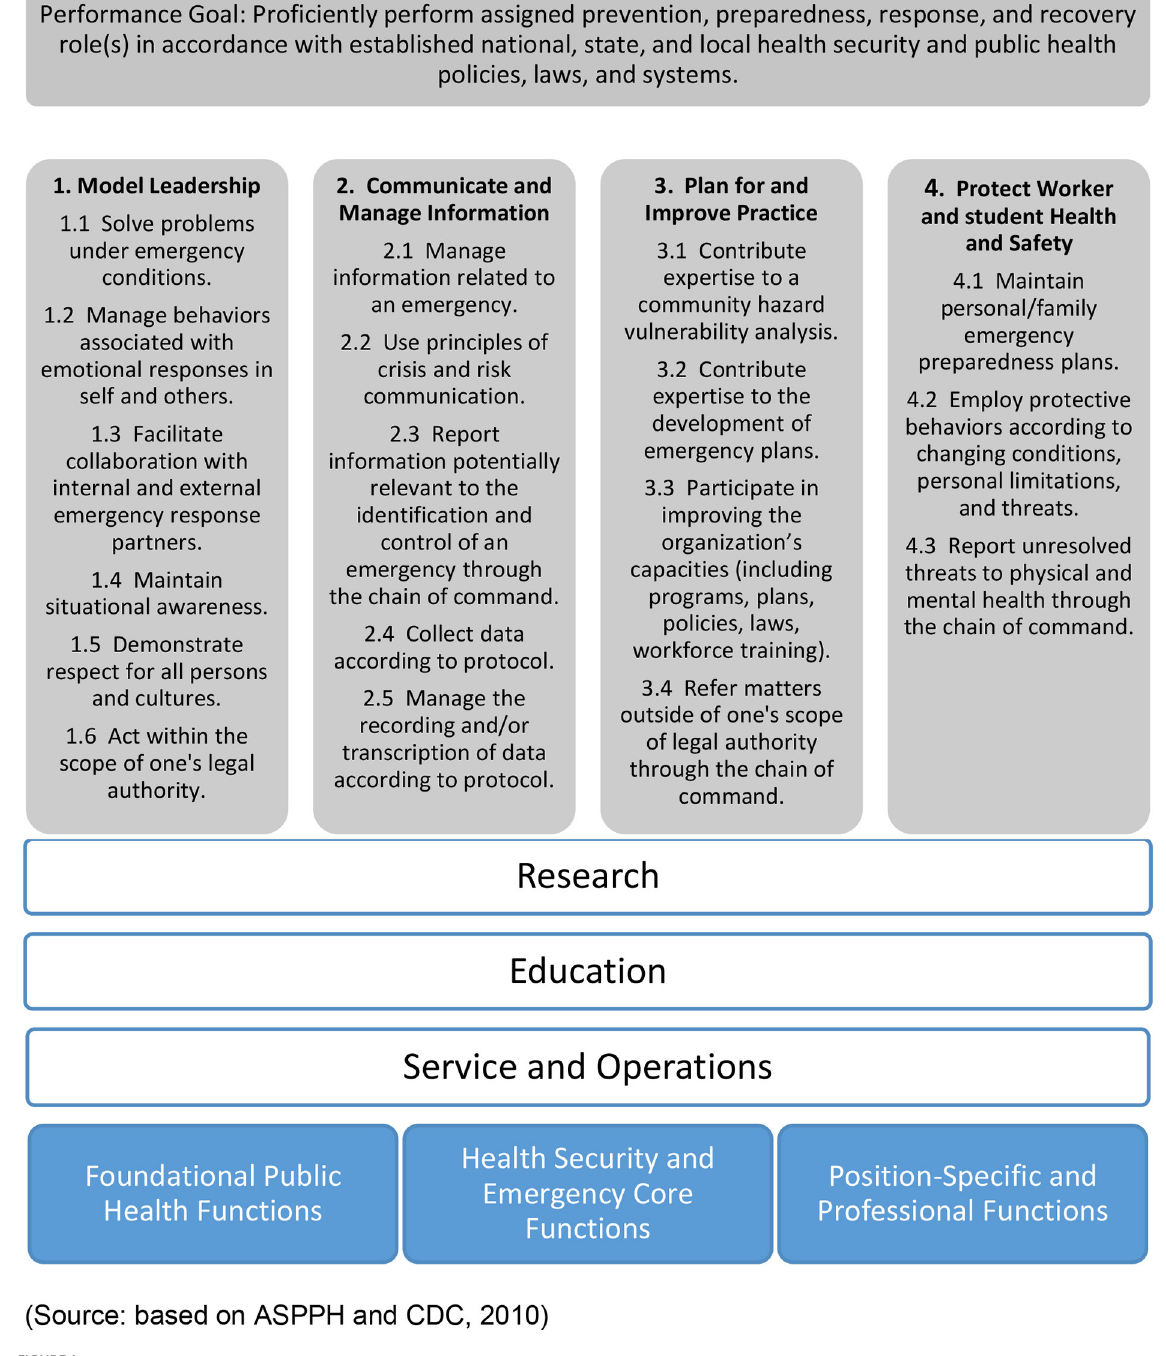
FIGURE1 Modified framework for public health response